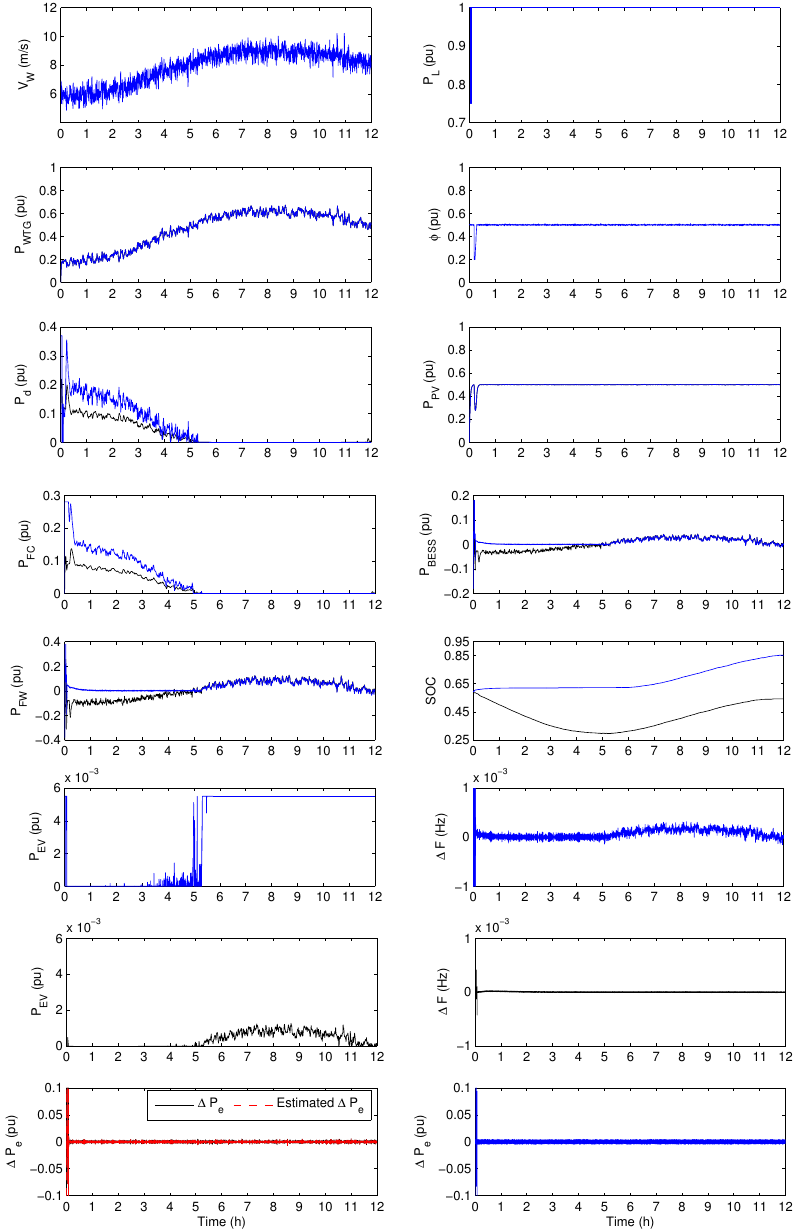
Figure 12. Case 5 simulation results: proposed (black) and conventional